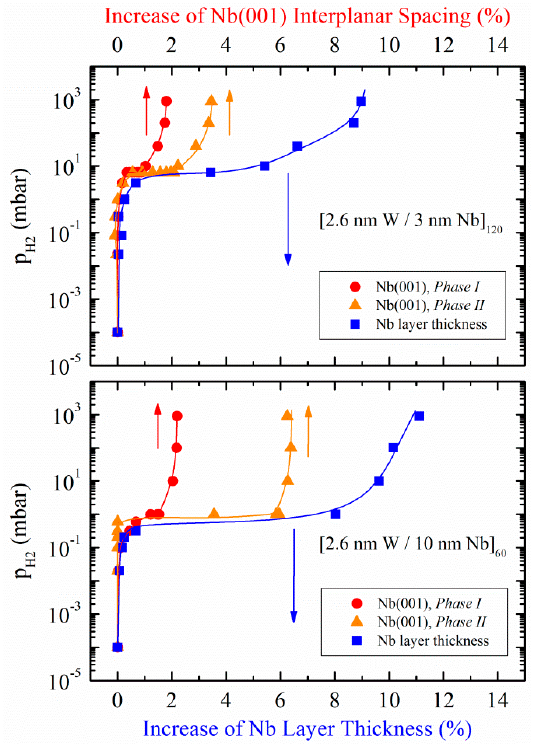
Figure 12. Comparison between hydrogen ‐ induced relative increase of the out ‐ of ‐ plane Nb(110) interplanar spacing ( top ); and increase of the Nb layer thickness ( bottom ) in W/Nb multilayers for various hydrogen pressures.